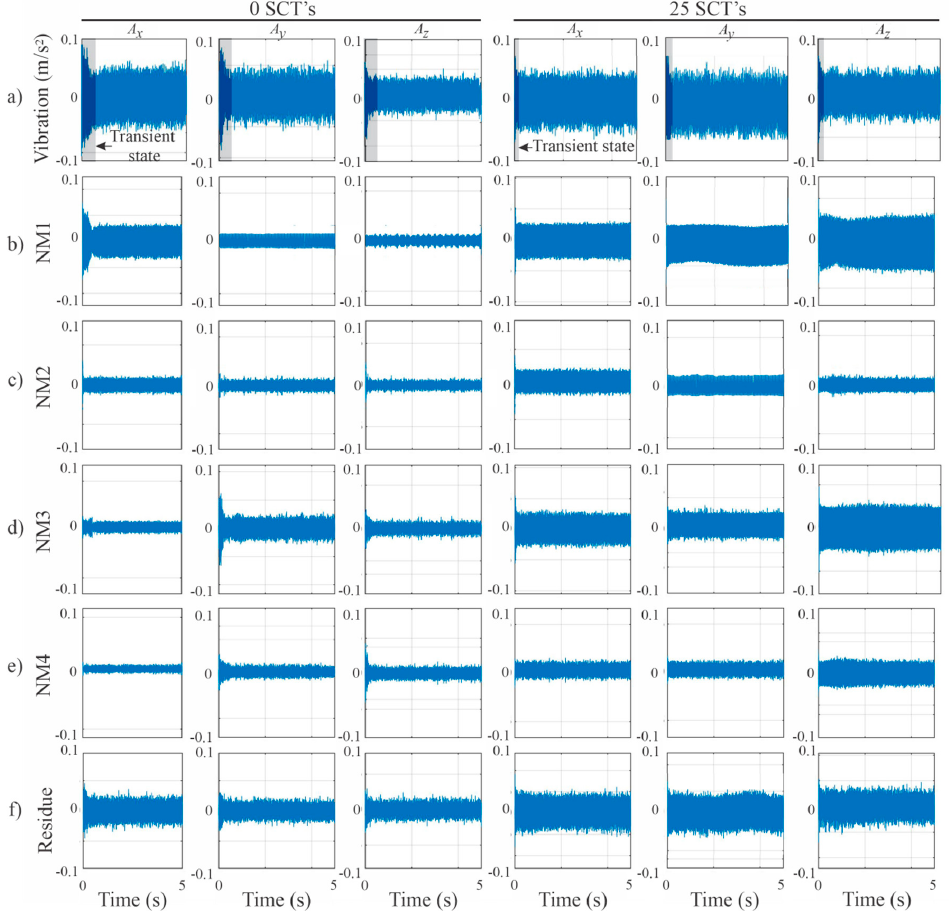
Figure 3. ( a ) Vibration signals, ( b ) nonlinear mode 1 (NM1), ( c ) nonlinear mode 2 (NM2), ( d )